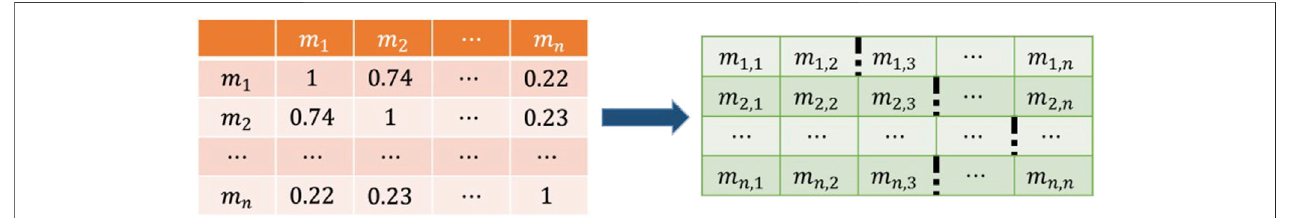
FIGURE 6 | According to the p -value of each similarity sequence, the valuable information corresponding to it is retained.